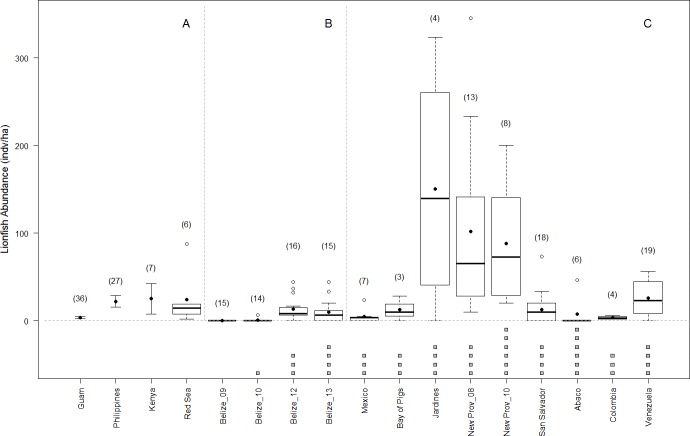
Lionfish abundance on reefs in native and invaded range.Lionfish abundance values published for similar reef habitats and similar depth ranges across the native (A) and invaded range (this study, and other studies B–C, respectively) showing boxplots of site-level data when available. Averages are shown in solid circles. When site-level data was not available, averages are transected by error bars showing published standard deviation. Number of sites surveyed within each region are shown in parentheses. Below the axis, grey boxes indicate number of years since the invasion at the time of the survey of invaded regions. Sources for lionfish density values include (Kulbicki et al., 2011; Agudo & Salas, 2014; Cure, McIlwain & Hixon, 2014; Valdivia et al., 2014; Bayraktarov et al., 2014; McTee & Grubich, 2014; Anton, Simpson & Vu, 2014).